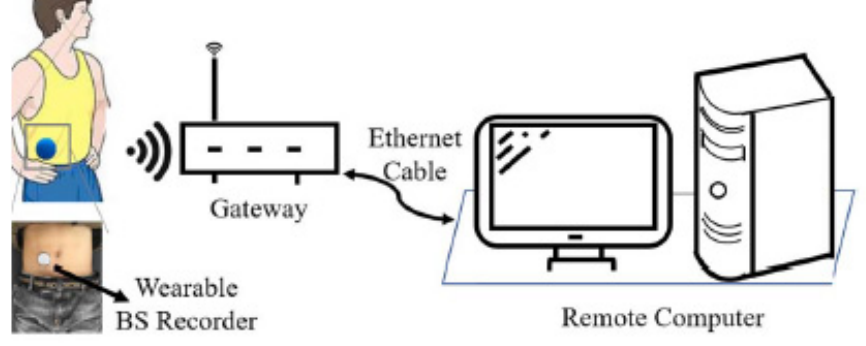
Figure 2. The wearable bowel sound system of surveillance (Zhao et al., 2022